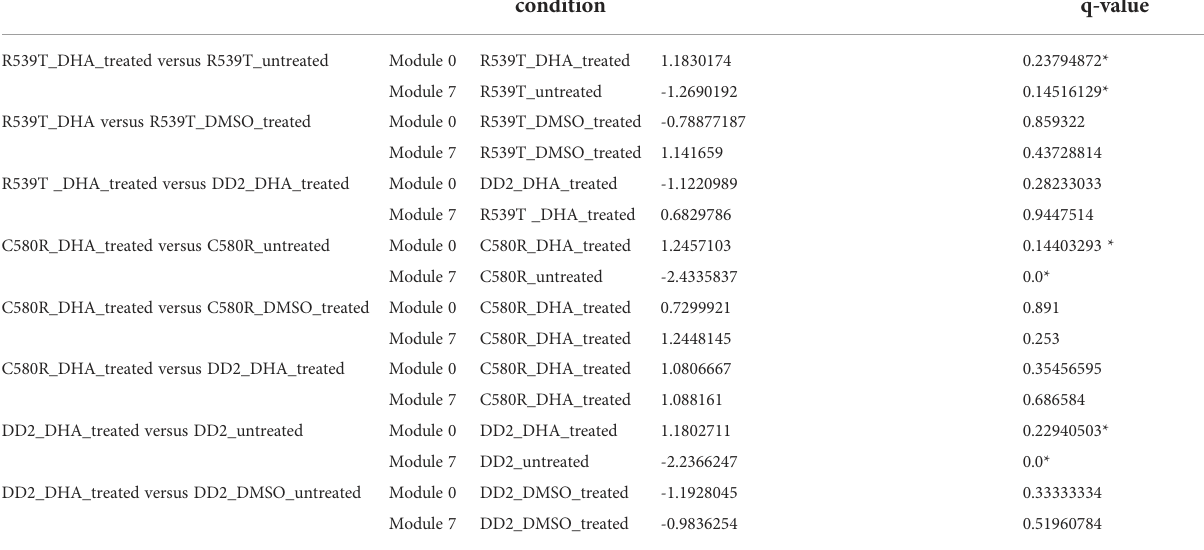
TABLE 2 Association of modules with the ARTr phenotype. Only 2 out of the 17 modules tested - modules 0 and 7- were associated with the ARTr phenotype. Treatment conditions